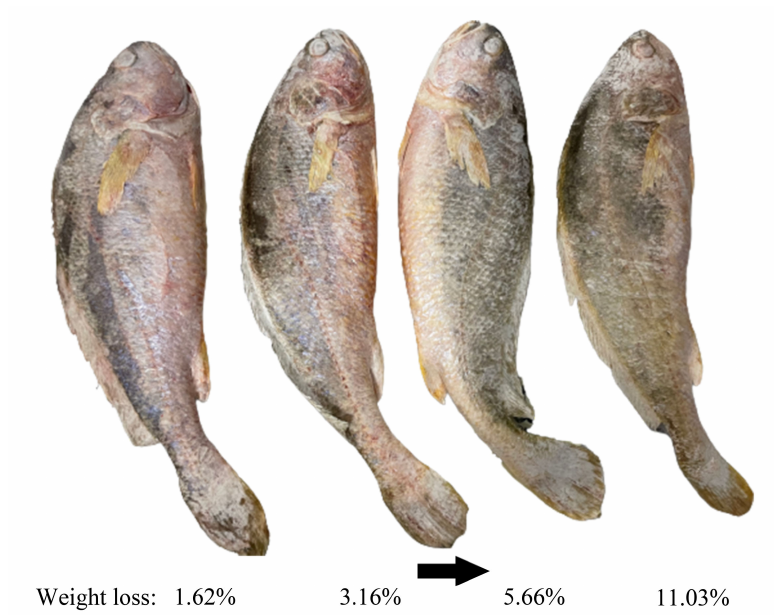
Figure 4. Effect of water sublimation on the surface color of large yellow croakers during frozen storage. The figure was created from own experimental images by the